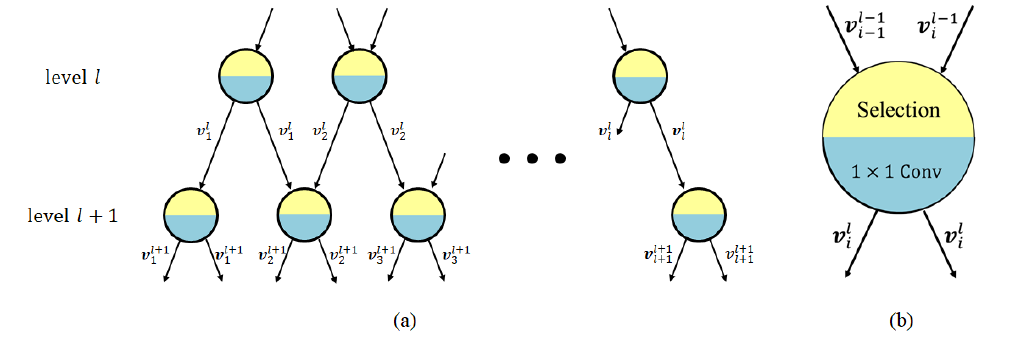
Figure 4. Node selection in the binomial tree layer: ( a ) For vectors of l nodes at level l , we perform local classification of l classes using the vector length. Each vector information is transmitted to the appropriate nodes at the next level; ( b ) we select the vector with larger length and apply a 1 × 1